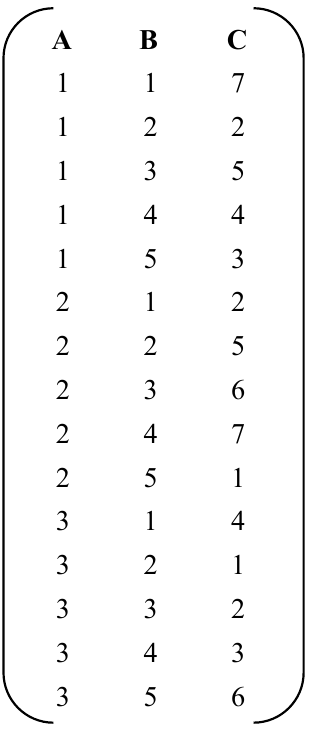
Figure 4. EA (15, 3 1 5 1 7 1 ).